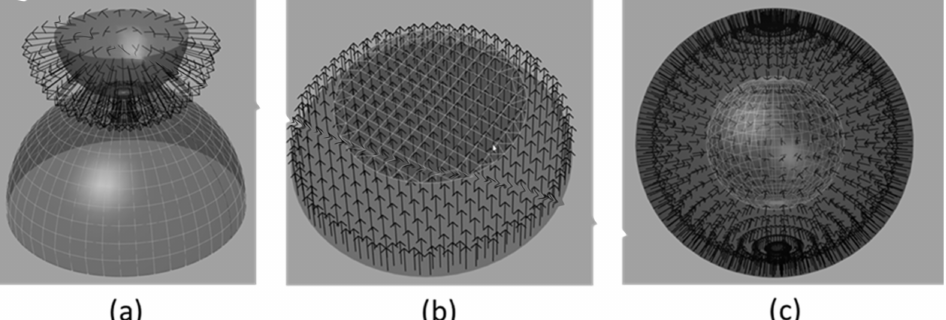
Figure 15. An assortment of curved shapes whose view factors can be calculated by the planar sub-division and ray-arrangement for each shape. As explained previously, once the view factors between rays and finite planar shapes have been calculated, further results can be derived through superposition rule. ( a , c ) Show open and closed curved surfaces respectively while ( b ) shows two open flat